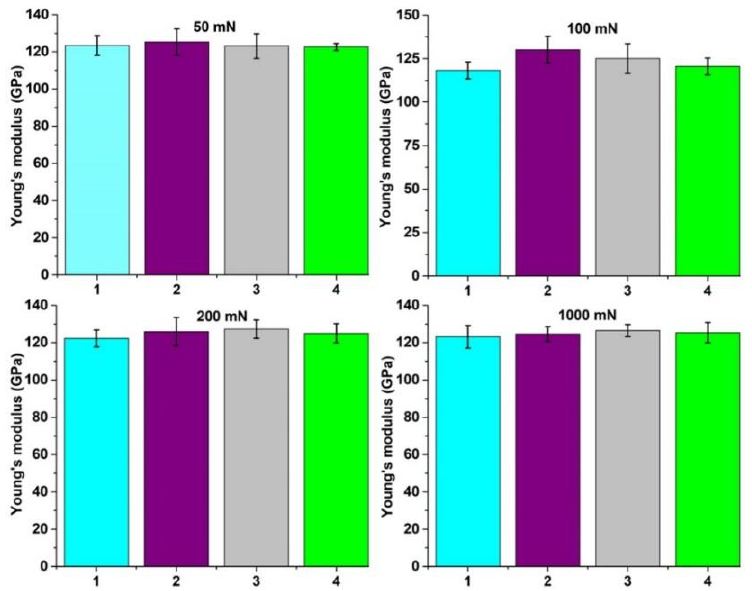
Figure 6. Elastic modulus of samples: (1) quenched in the oven, (2) quenched in water, (3) quenched in oil, and (4) without thermal treatment. in oil, and (4) without thermal treatment .